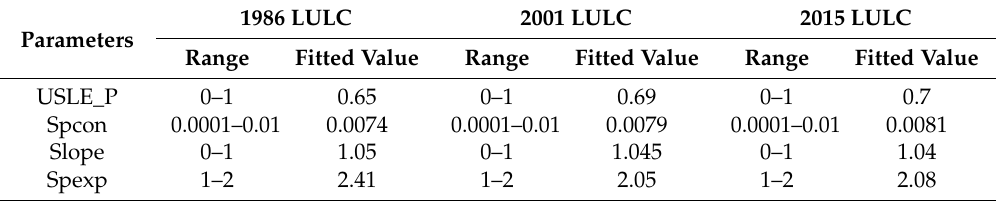
Table 6. Selected parameters fitted values during model calibration and validation for sediment yield.